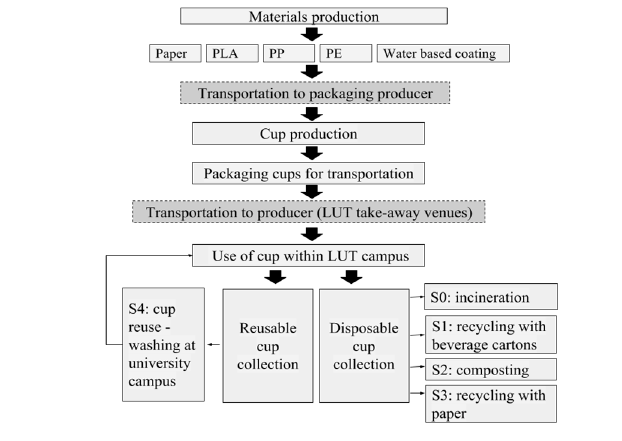
Figure 2. General process flow diagram.